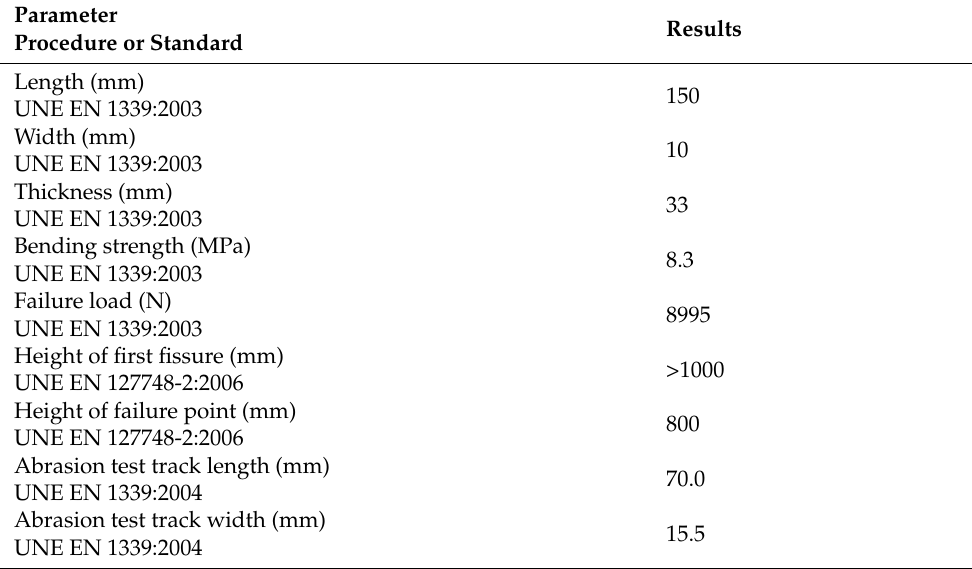
Table 4. Physicochemical characteristics of the concrete paving tiles